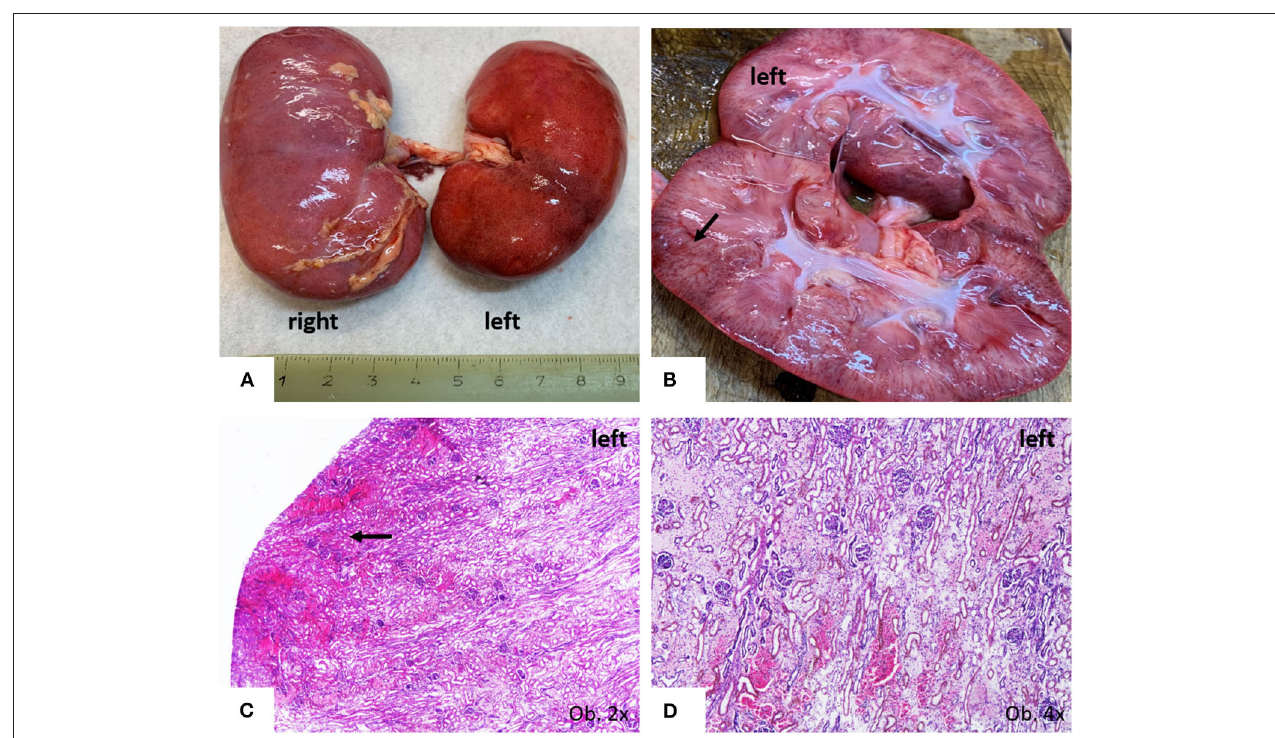
FIGURE 5 | Gross findings of kidneys. (A) Bilateral enlargement, with hyperaemic surface of the left kidney; (B,C) Passive hyperemia of the cortex; (C,D) Parenchymatous congestion, with interstitial edema.